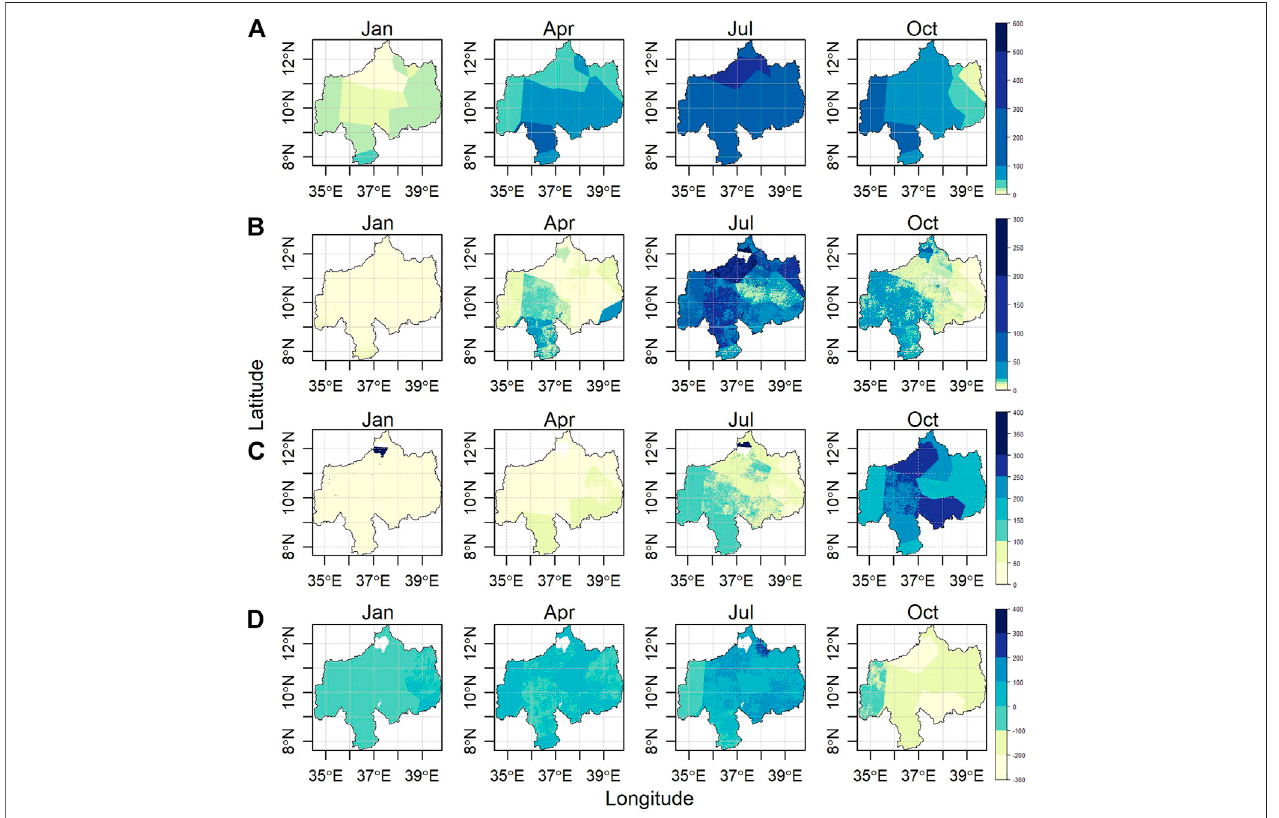
FIGURE7| Spatialdistributionoflong-termmeanmonthlywaterbudget(January,april,July,andOctober)intheUBNRB.Labels (A) , (B) , (C) and (D) representthe entire row. Maps for the remaining months are given in supplement.